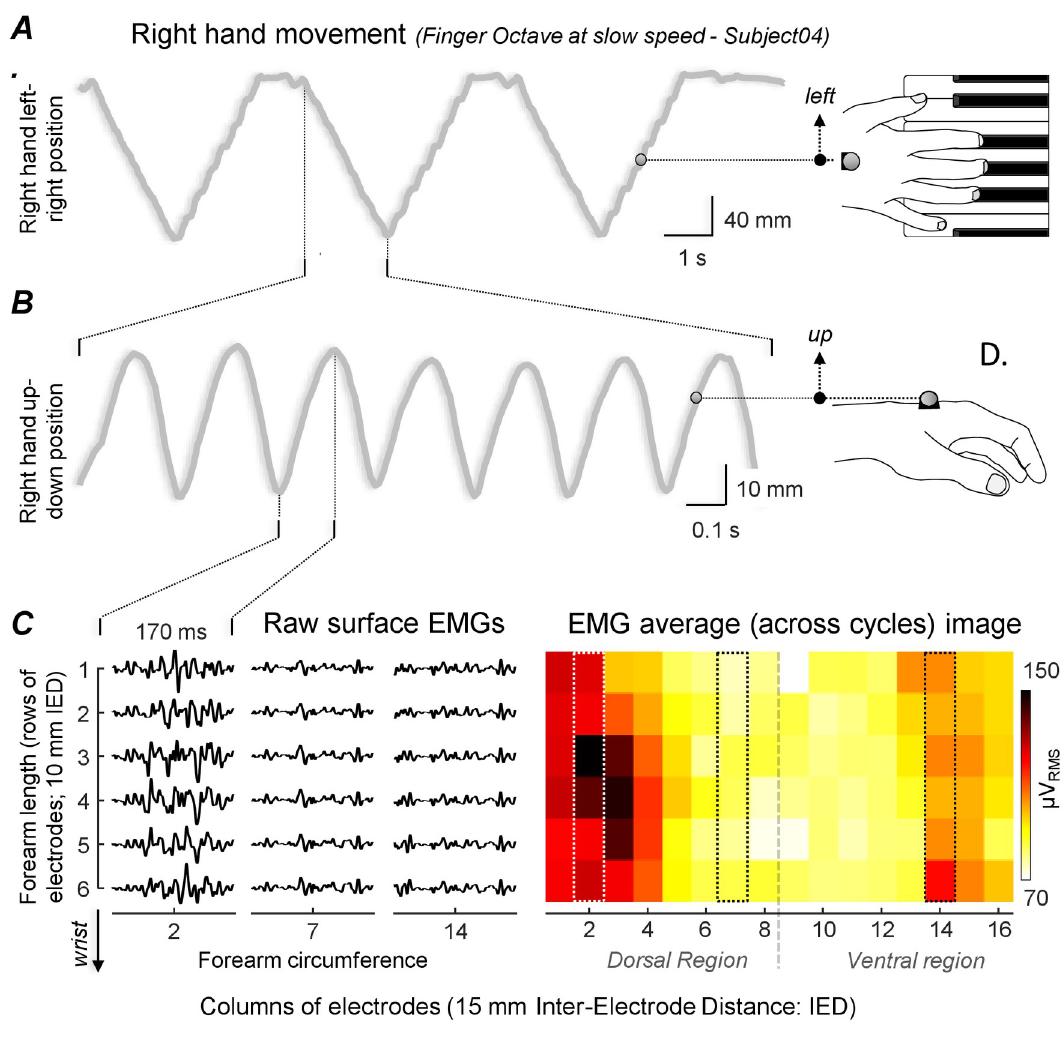
Fig 2. Computation of EMG maps for octaves. Hand trajectories along the lateral and the craniocaudal axes are illustrated respectively in panels A and B for a representative subject during wrist octaves. Raw EMGs detected by all electrodes in columns 2, 7 and 14 during an upward phase of the up-down hand trajectory cycles are shown in panel C (left), together with the Root Mean Square (RMS) amplitude of each monopolar EMG averaged across cycles